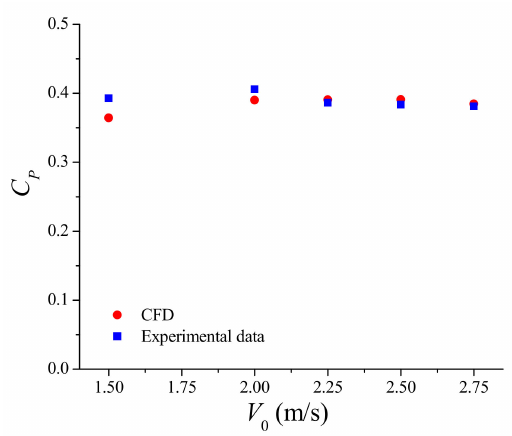
Figure 6. Validation of the numerical model in this study by the experimental results of Song et al. [26] for the three-blade